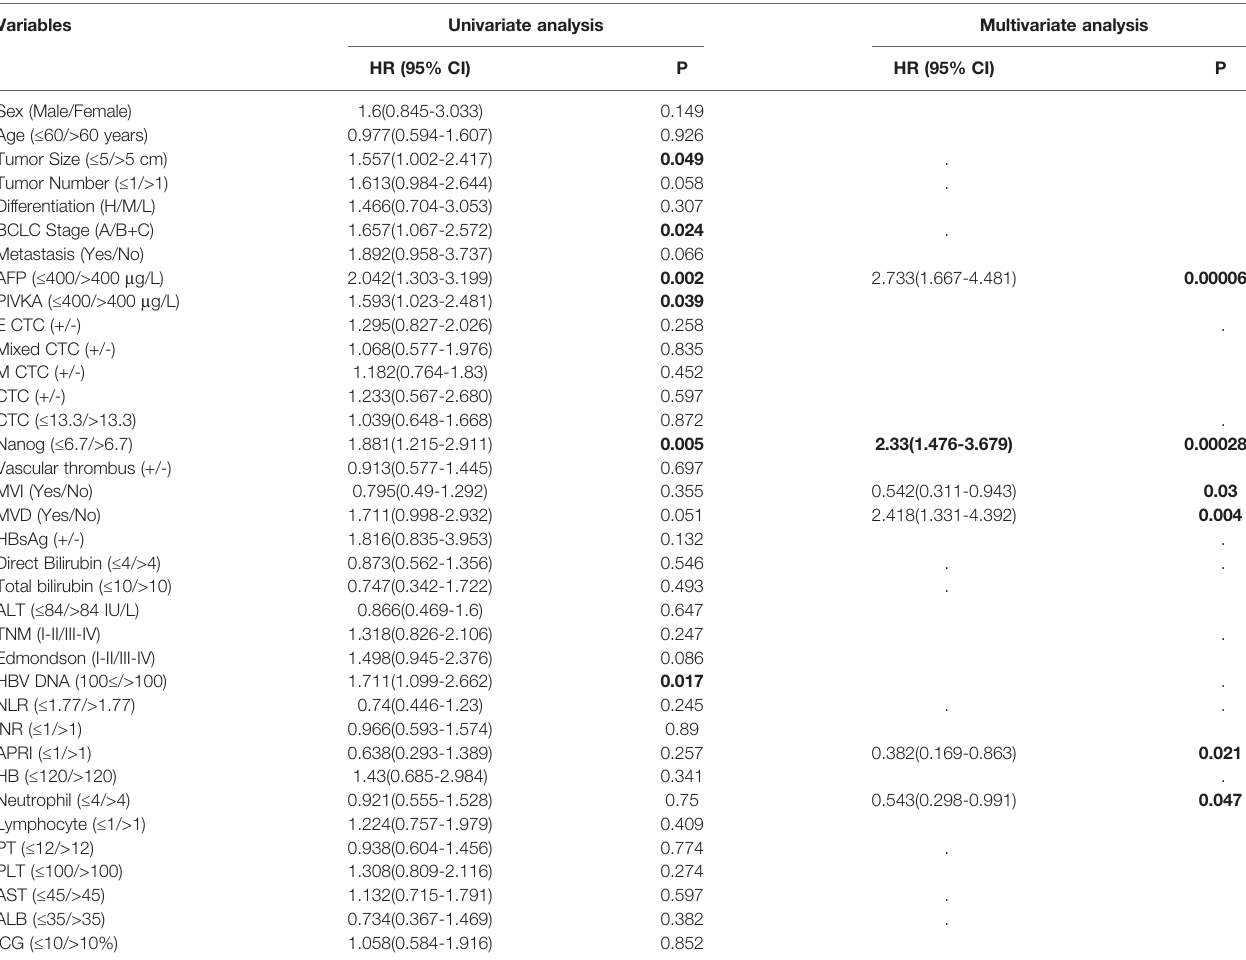
TABLE 3 | Cox proportional regression analysis of univariate and multivariate. Variables Univariate analysis Multivariate